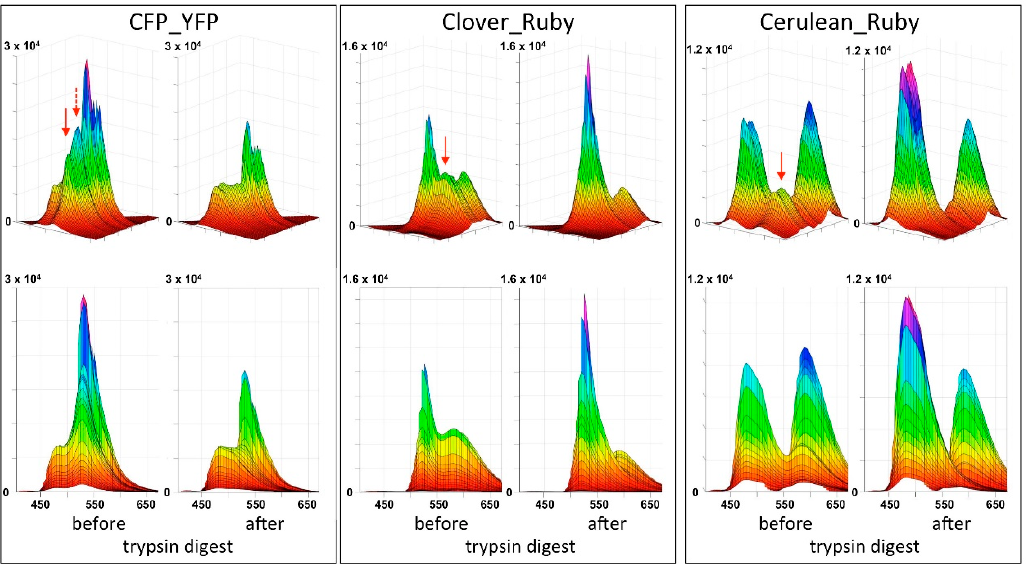
Figure A3. 3D fluorescence spectra of FRET fusion constructs. The three different fusion constructs were analyzed as described in the text. The upper panel shows the same representation as used for Figure A2, while the lower panel takes the quasi two-dimensional perspective, which facilitates quantitative comparison. Red arrows indicate the position of the FRET signals. The dotted red arrow in the CFP_YFP spectrum indicates a second FRET peak where the donor emission contribution is twice as high as in the first peak. With the CFP-YFP pair, a strong loss of the YFP signal resulting from direct excitation (non-FRET) after trypsin treatment is evident, as well as a lack of increase in the CFP signal after proteolytic digest. The latter is expected when FRET is abolished as a dequenching effect. Such an effect is observed for mClover3 (middle panel) and mCerulean3 (right panel) after trypsin digest. At the same time, a slight loss in the mRuby3 fluorescence signal in the right hind corner of the respective spectra can be observed after proteolysis. The excitation/emission wavelength maxima for the FRET signals were at 425/530 nm for CFP_YFP (460/530 nm for the second peak), 490/580 nm for mClover3_mRuby3, and a double peak at 425/585_450/585 for mCerulean3_mRuby3.